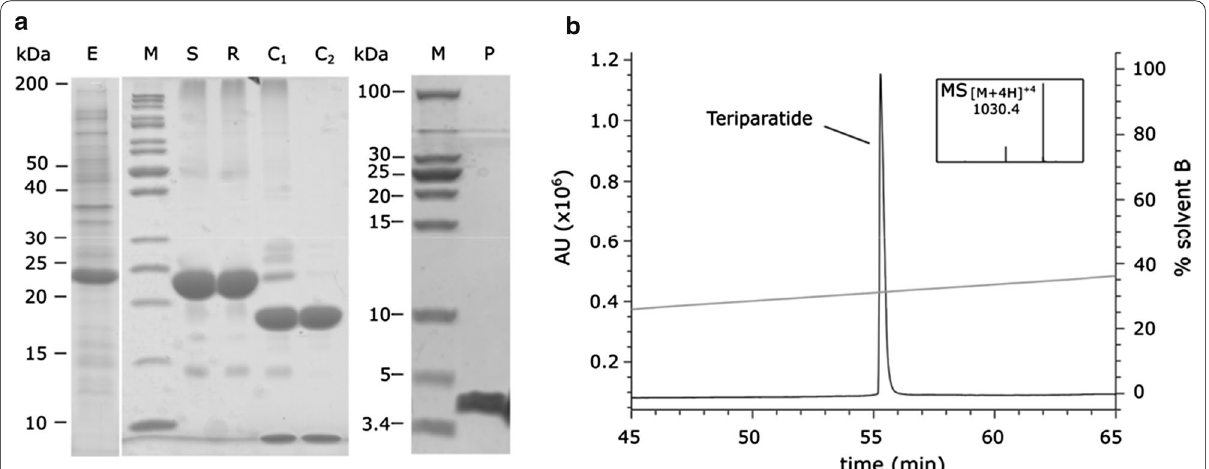
Fig. 5 Numaswitch applied to produce Teriparatide a SDS‑PAGE analysis of different process steps; E. coli cells from high cell density fermentation (E), solubilized Switchtag Teriparatide IBs (S), renaturation reaction (R), TEV protease cleavage (C1: crude, C2, cleared) and produced Teriparatide after CEX, RP FLASH purification and TFA/acetate exchange (P). M: Molecular weight marker with shown masses. b HPLC/MS analysis of purified Teriparatide revealed > 99.6% purity of lyophilized